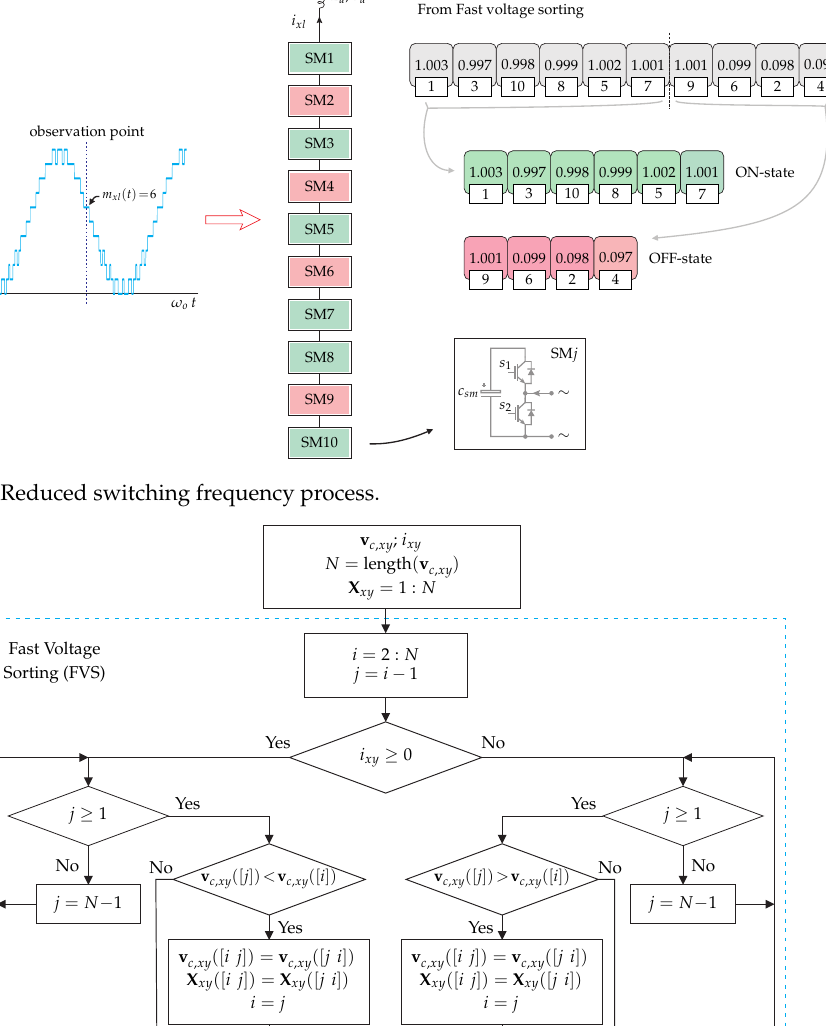
Figure 10. General submodule voltage balancing algorithm